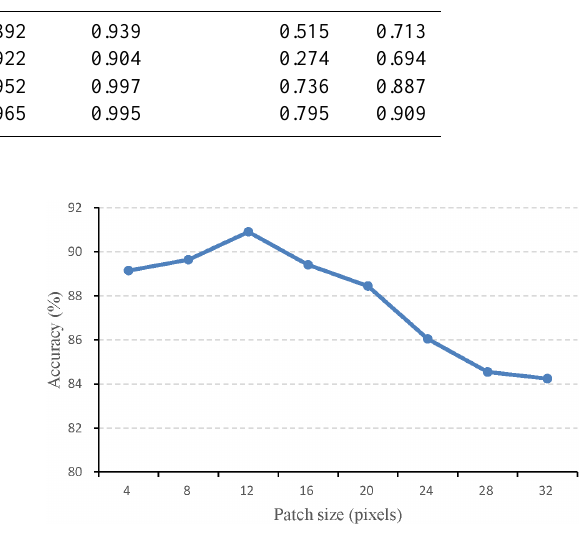
Figure 8. The curve of overall accuracy of BoMS with different patch